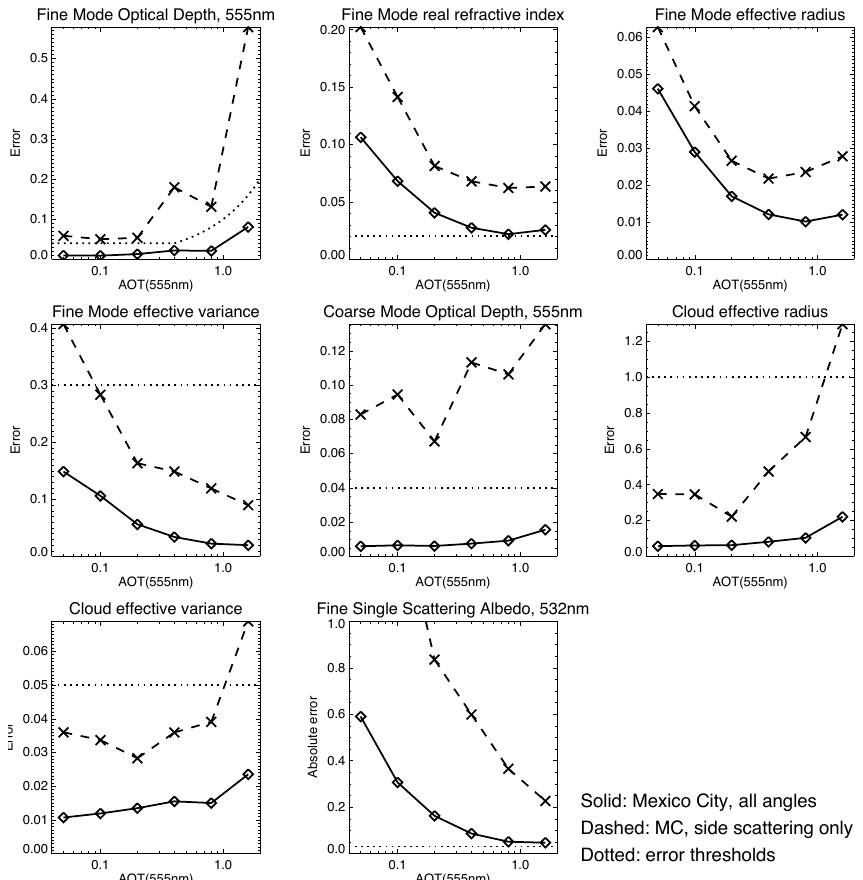
Fig. 6. Simulated retrieval error for “Mexico City” type aerosols (see Dubovik et al., 2002) suspended above a marine stratocumulus cloud. The aerosols, which were placed in a uniform layer between 550 and 750m above sea level, were simulated at a variety of optical depths. The x-axis of each plot is the fine mode aerosol optical depth at 0.555µm. Coarse mode optical depth was maintained at 20% of the fine mode value for each simulation. The marine stratocumulus cloud had an effective radius of ( r e , cl = 6 . 25µm) and effective variance of ( v e , cl = 0 . 075), an optical depth of 10, and was uniformly distributed (with respect to pressure) from the ground to 480m. Solid lines are the simulated errors for an observation including all view zenith angles within (60 ◦ ) of nadir, which is similar to our scene and includes the cloud bow (and corresponds to a scattering angle range of (85 ◦ ) to (150 ◦ )). Dashed lines are the simulated errors for an optimization that only uses observations at angles between (20 ◦ ) and (60 ◦ ) in the forward direction, which excludes the cloud bow and is similar to the method of Waquet et al. (2009b), who had greater uncertainty when determining cloud parameters. These angles correspond to a scattering angle range of (85 ◦ ) to (120 ◦ ). Dotted lines are the accuracy thresholds described in Mishchenko et al. (2004) required to improve aerosol climate models. It is important to note that these values are intended for retrievals of aerosols in the absence of clouds or clouds in the absence of aerosols - not AAC. Also, the threshold for effective radius (top right) is (0.1µm), greater than all the simulated errors in that plot. The single scattering albedo (bottom, center) accuracy threshold is 0.03, less than all simulated error